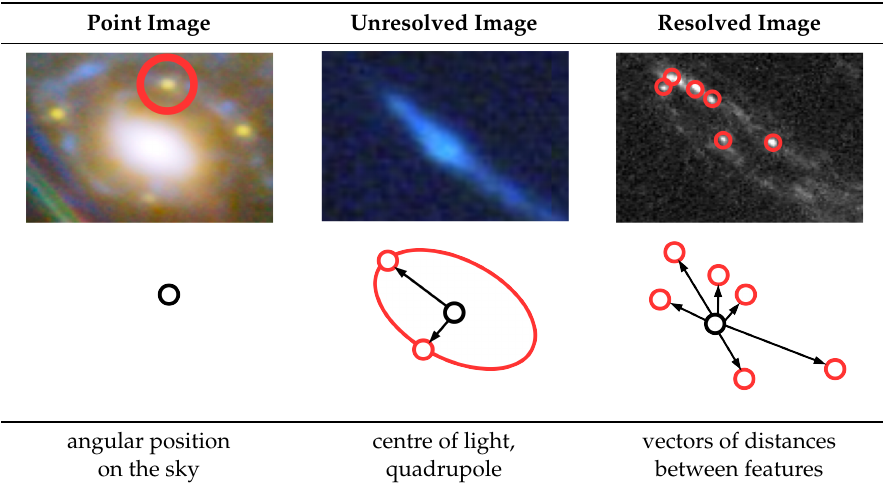
Table 1. Types of multiple images and quantitative observables that can be extracted from each image. Each type can occur in different multiple-image configurations shown in Table 2. Image credits: NASA/ESA/HST